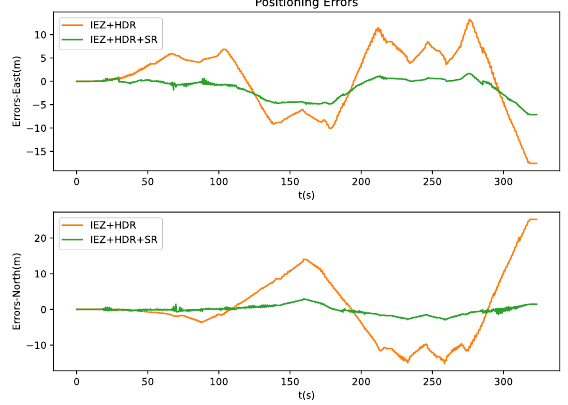
Figure 11 . Horizontal positioning errors (Experiment 2).